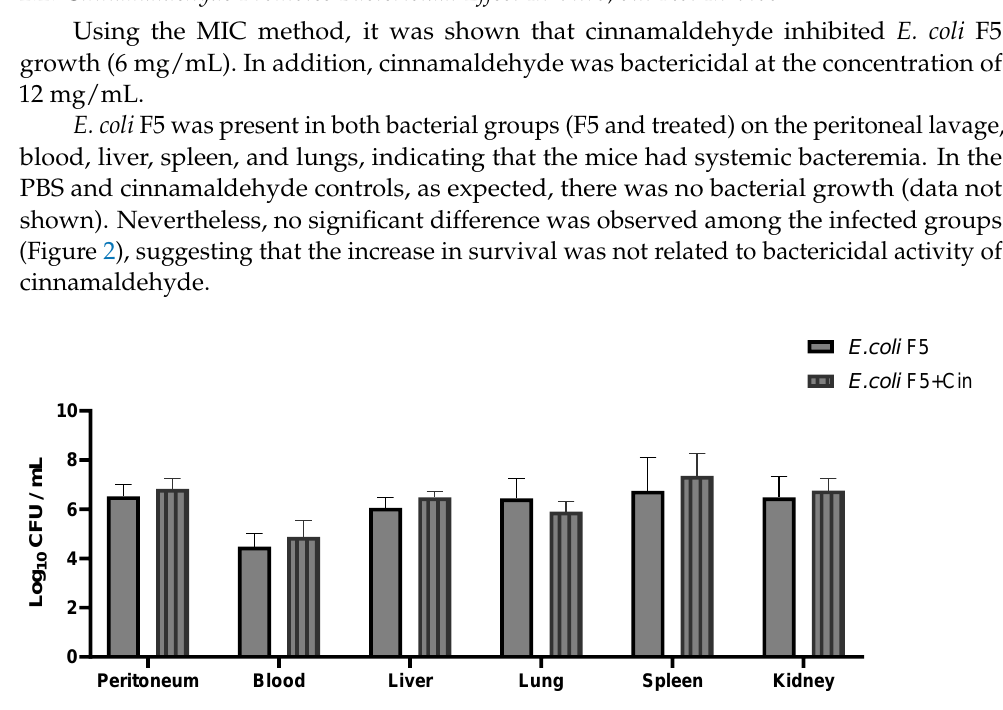
Figure 2. CFU counting from blood, peritoneal lavage, lungs, liver, spleen, and kidneys from animals infected with E. coli F5 and cinnamaldehyde treatment. The animals used in the experiment were distributed into 4 groups ( n = 6). The groups received E. coli F5 or E. coli F5 followed by cinnamaldehyde treatment 60 mg/kg after two hours. After 10 h, the mice were euthanized. Aliquots of peritoneal fluid and blood were diluted in sterile PBS and serial dilutions were cultivated on MacConkey for evaluation of CFU. To quantify bacteria in the organs, part of them were macerated, and dilutions were cultivated on MacConkey. After overnight incubation at 37 °C, the CFUs were counted, and the results expressed as Log of CFU/mL.